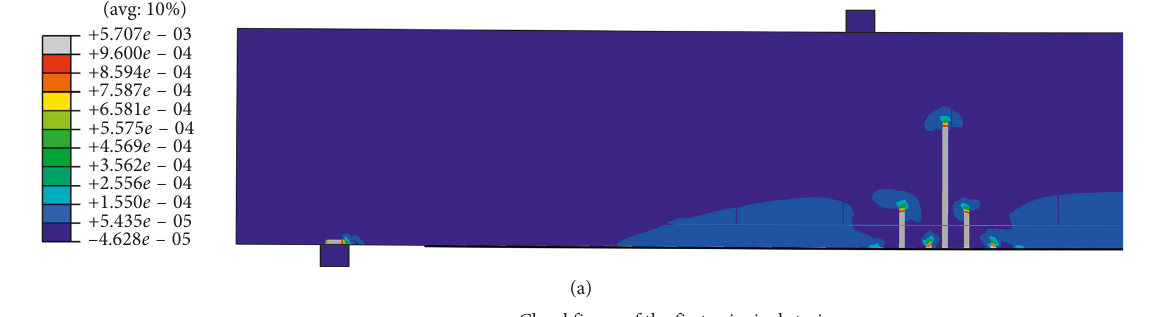
Cloud figure of the first principal strain